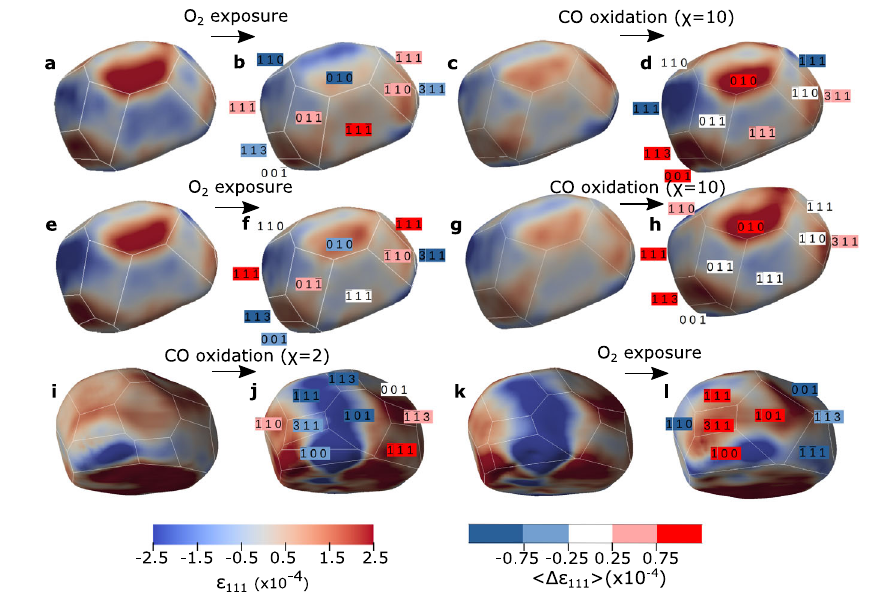
Fig. 5 Strain evolution during O 2 adsorption and CO oxidation for NP300. a – d 1st cycle: a Ar, b Ar + O 2 : 2.5% (14 min. exposure), c Ar + O 2 : 2.5% (59 min. exposure) and d Ar + CO: 25% + O 2 : 2.5% (10 min. exposure). e – h 2nd cycle: e Ar, f Ar + O 2 : 2.5% (10 min. exposure), g Ar + O 2 : 2.5% (76 min. exposure) and h Ar + CO: 25% + O 2 : 2.5% (19 min. exposure). i – l 3rd cycle: i Ar + O 2 : 12.5% (70 min. exposure), j Ar + CO: 25% + O 2 : 12.5% (21 min. exposure), k Ar + CO: 25% + O 2 : 12.5% (53 min. exposure) and l Ar + O 2 : 12.5% (13 min. exposure). The colour coding of the Miller indices denotes the variation of the average strain per facet Δ 〈 ϵ 111 〉 with respect to the previous